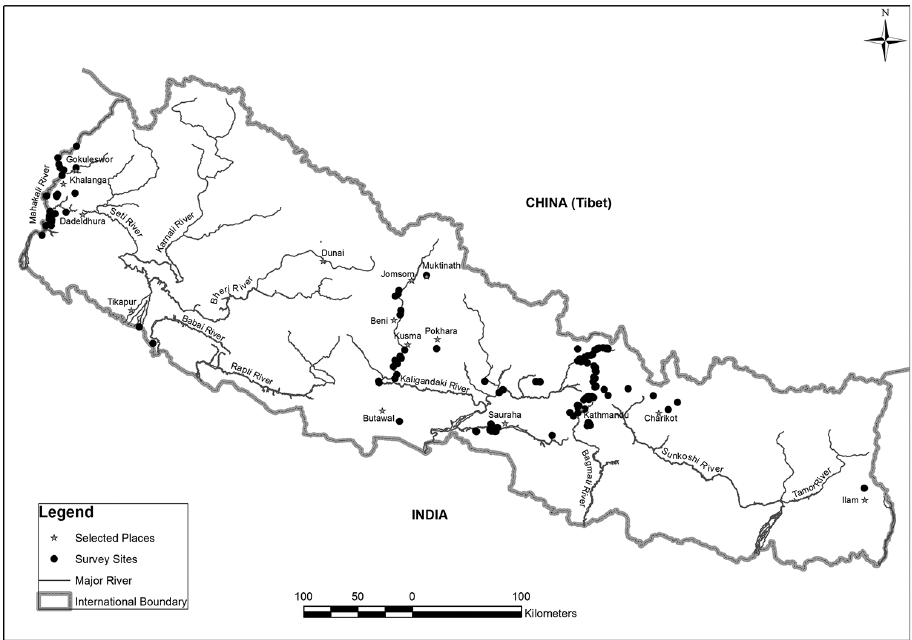
Figure 1. Collecting locations for glessulines in